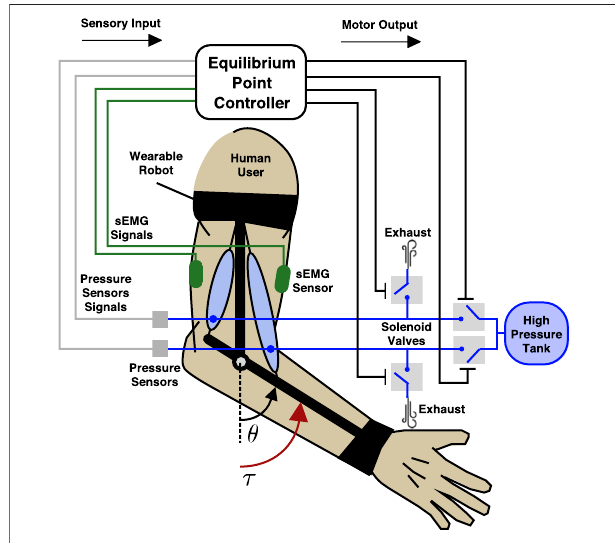
FIGURE1| Schematicrepresentationofanelbowassistwearablerobot used as an idealized model to conceptually demonstrate our proposed equilibrium-point controller. The wearable robot exerts a torque τ about the elbowjointwithangle θ .Thewearable robot consists oftwoantagonistic soft pneumatic actuators and a support structure and is attached across the human user ’ s elbow joint. The soft actuators are driven through solenoid valves, one for high pressure and one for exhaust. Pressure sensors monitor the internal pressure of each pneumatic actuator, while two sEMG sensors monitor the agonist (bicep) and antagonist (tricep) biological muscles. The researchproblemweaimtosolveisgiventhesensoryinputs(internalpressure and sEMG) to choose the appropriate motor outputs (valve on/off states) in order to provide physical assistance to the user.